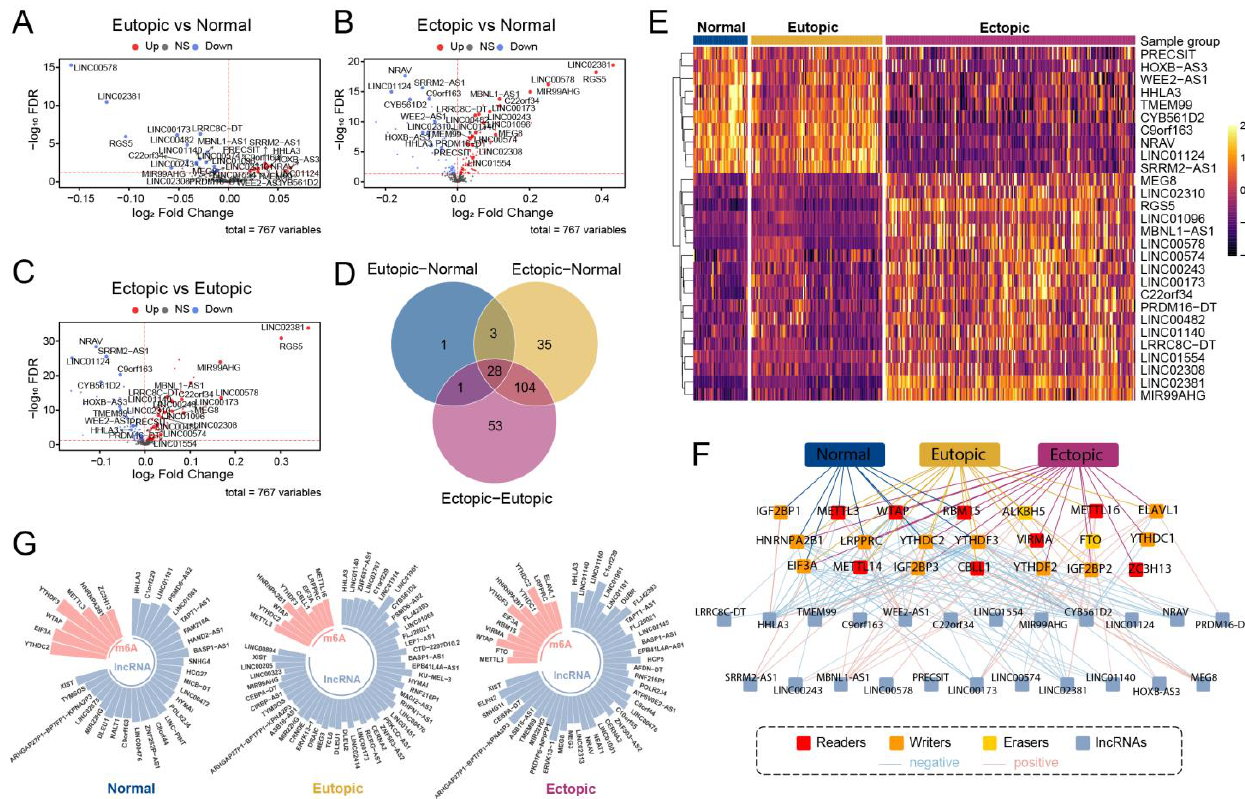
Figure 5. Analysis of m6A regulators-related lncRNAs. ( A – C ) The volcano plots showed significant variations in these related lncRNAs in eutopic vs. normal, ectopic vs. normal, and ectopic vs. eutopic groups. The upregulated genes marked in red, the downregulated in blue and gray indicated not differential expressed. The overlapping lncRNAs among 3 differential results were exhibited in the Venn plot ( D ), and their expression in the heatmap ( E ). ( F ) A robust LACN consisted of m6A regulators with interacting lncRNAs in normal, eutopic and ectopic groups. ( G ) Random walk algorithm determined key nodes in normal, eutopic and ectopic groups, respectively, using Rose Charts.